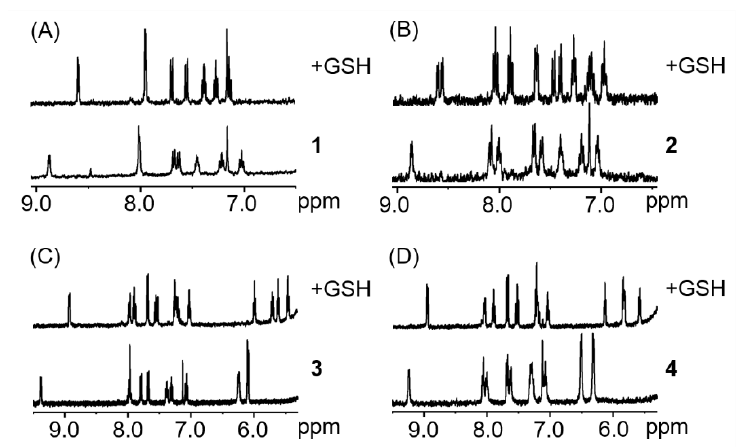
Figure 5. 1 H-NMR spectra of complexes 1 – 4 ( A – D , respectively) in the presence of 2 mol. equiv. of GSH after less than 10 min (1.1 mM complex, MeOD / D 2 O 1:1 v / v , pH 7.4, 298 K).